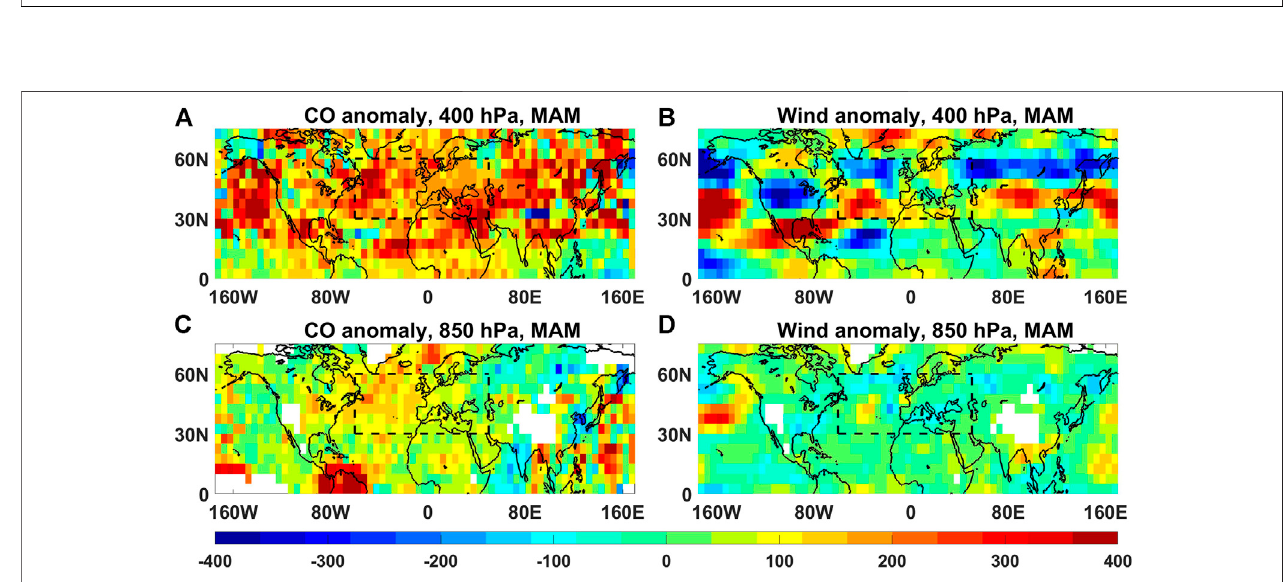
FIGURE11|(A) CO fl uxdifference(unit:ppbv m s − 1 )inCOanomalybetweenElNiñoandLaNiñayearsinMAMat400 hPa. (B) CO fl uxdifferenceinwindanomaly betweenElNiñoandLaNiñayearsinMAMat400 hPa. (C) Thesameas (A) ,butat850 hPa. (D) Thesameas (B) ,butat850 hPa.See Eq.3 forthetermde fi nitions.The white areas in 850 hPa are due to topography.